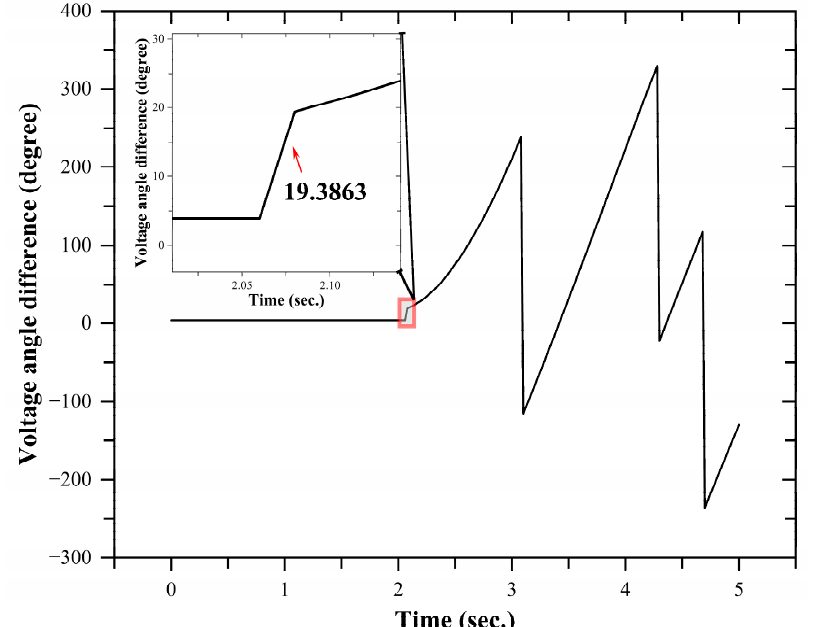
Figure 15. Proposed unintentional island threshold technique for over frequency Scenario 1.